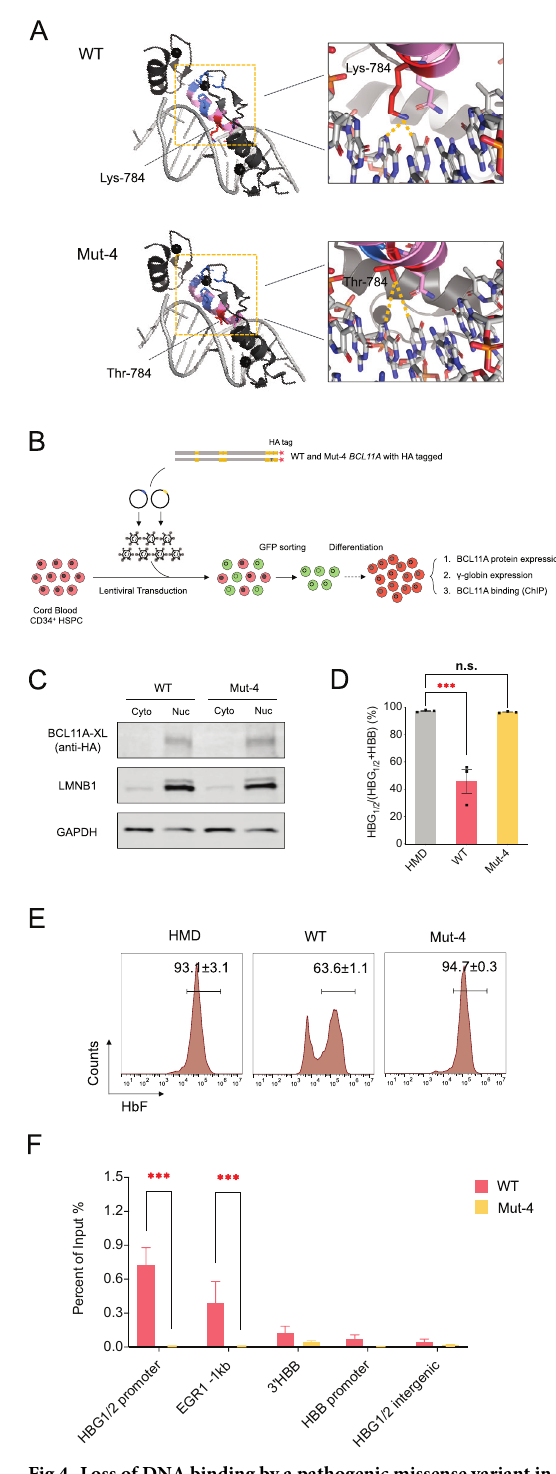
Fig 4. Loss of DNA binding by a pathogenic missense variant in BCL11A ZnF5 underlies impaired HbF silencing. (A) Left panel: Structure of ZnF5 for wild type and Mut 4 (p.Lys784Thr) form of BCL11A. Right panel: Zoom in view of ZnF5 indicating DNA binding alteration between wild type (Lys-784) and Mut 4 (Thr-784). (B) Workflow of exogenous expression of either the wild type or Mut 4 forms of the BCL11A XL with a HA-tag at C terminal in cord blood HSPCs showing lentiviral transduction, GFP sorting, erythroid differentiation, functional and binding